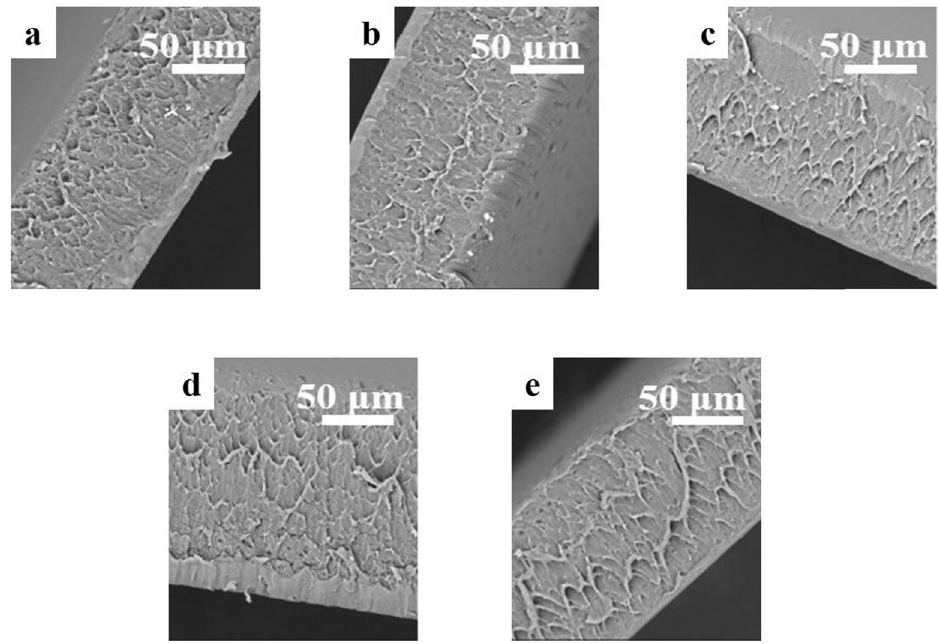
Figure 8: SEM images of surface and cross section of the SPI fi lms with and without MPE. ( a ) SPI control, ( b ) SPI - 1% MPE, ( c ) SPI - 5% MPE, ( d ) SPI - 10% MPE, and ( e ) SPI - 15%